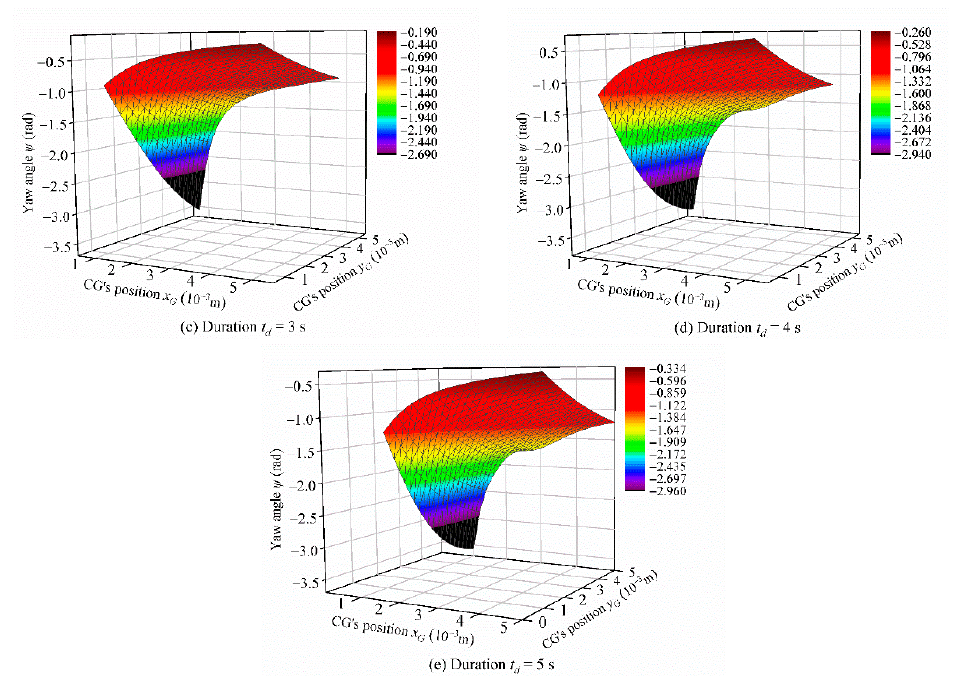
Figure 8. The effect of CG’s position x G , y G, and duration t d on yaw angle ψ .